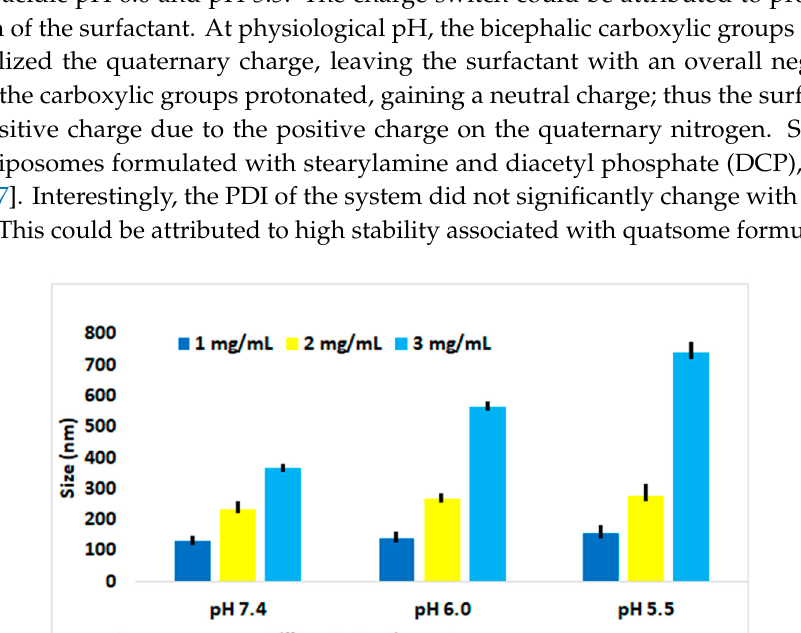
Figure 1. ( A ) Morphology of VCM-StBAclm-Qt 1 quatsomes scale bar: 200 nm and ( B ) size distribution of VCM-StBAclm-Qt 1 quatsomes measured using dynamic light scattering (DLS).